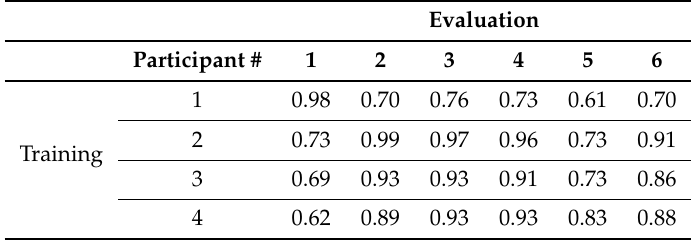
Table 9. Median accuracy rates for each combination of training and evaluation participants. Results were obtained through the use of a naive Bayesian classifier on RSS data from a 7-node 433 and 868 MHz network.